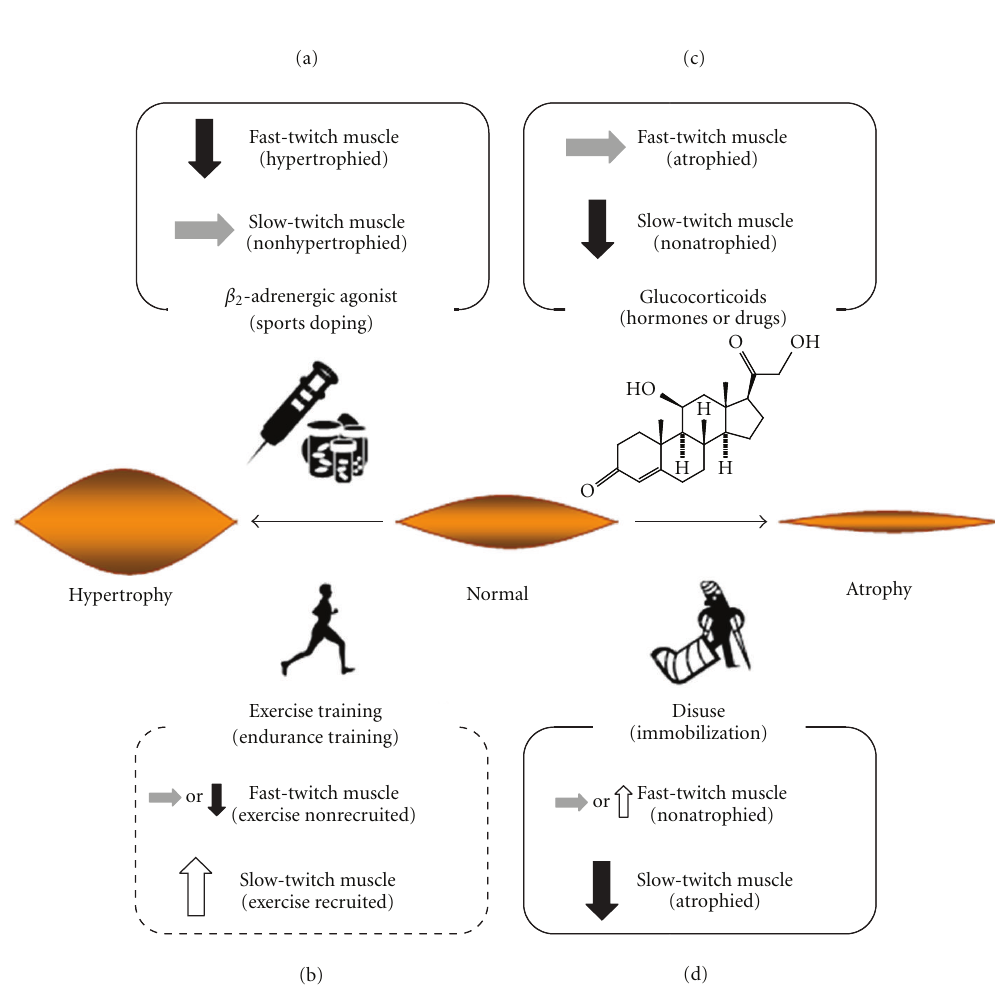
Figure 1: Changes in β 2 -AR expression in hypertrophied and atrophied skeletal muscles. (a) β -AR stimulation using anabolic drugs 2 downregulates β 2 -AR expression in hypertrophied fast-twitch muscles but not in slow-twitch muscles [4, 7, 8, 14–17]. (b) Exercise training such as endurance training upregulates β 2 -AR expression in exercise-recruited slow-twitch muscles, whereas no changes or downregulations are observed in fast-twitch muscles [18, 19], although muscle mass is not altered. However, although exercise training such as isometric strength training induces muscle hypertrophy, there is no insight regarding the e ff ects of such exercise on β 2 -AR expression. The di ff erential e ff ects of types of exercise training on physiological responses such as β 2 -AR expression and muscle hypertrophy should be clarified in more detailed and are currently being investigated by our group. (c) Catabolic hormones or drugs such as glucocorticoids downregulate β 2 -AR expression in nonatrophied slow-twitch muscles but not fast-twitch muscles [16, 20, 21]. (d) Muscle disuse downregulates β 2 -AR expression in atrophied slow-twitch muscle, whereas no changes or upregulation of receptor expression are observed in fast-twitch muscles [14, 22]. Up arrow (open arrow): upregulation of β 2 -AR expression; down arrow (filled arrow): downregulation of β 2 -AR expression; lateral arrow (shade arrow): no